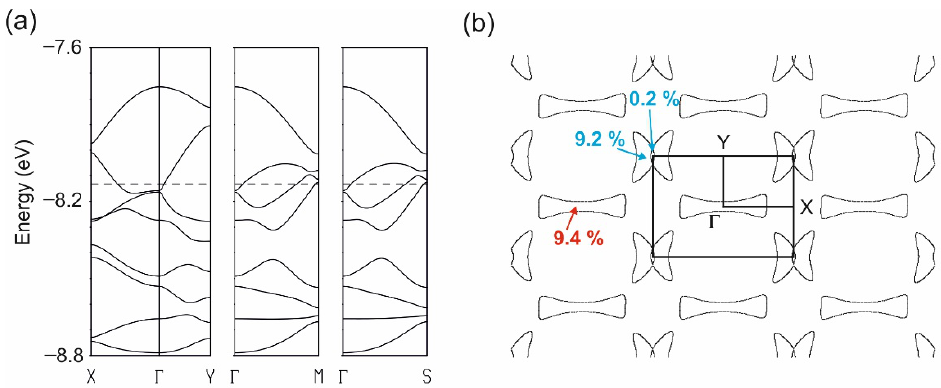
Figure 5. Calculated band structure ( a ) and Fermi surface ( b ) for the donor lattice of the low-